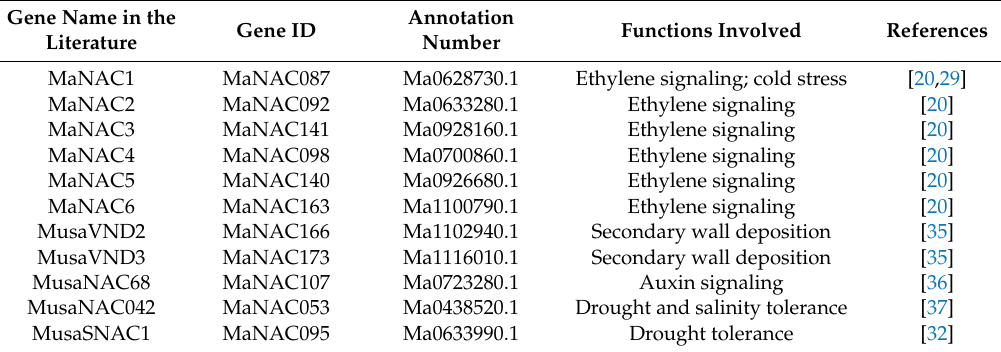
Table 1. Reported NAC genes in M. acuminata in the